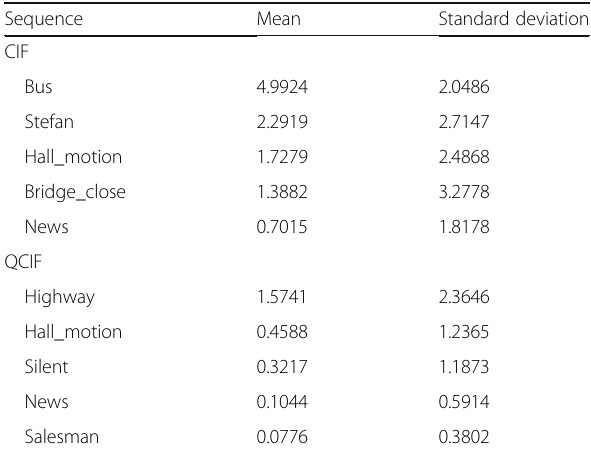
Table 3 Motion intensity of the five CIF and five QCIF sequences (the means and standard deviations of the magnitude of the motion vectors)